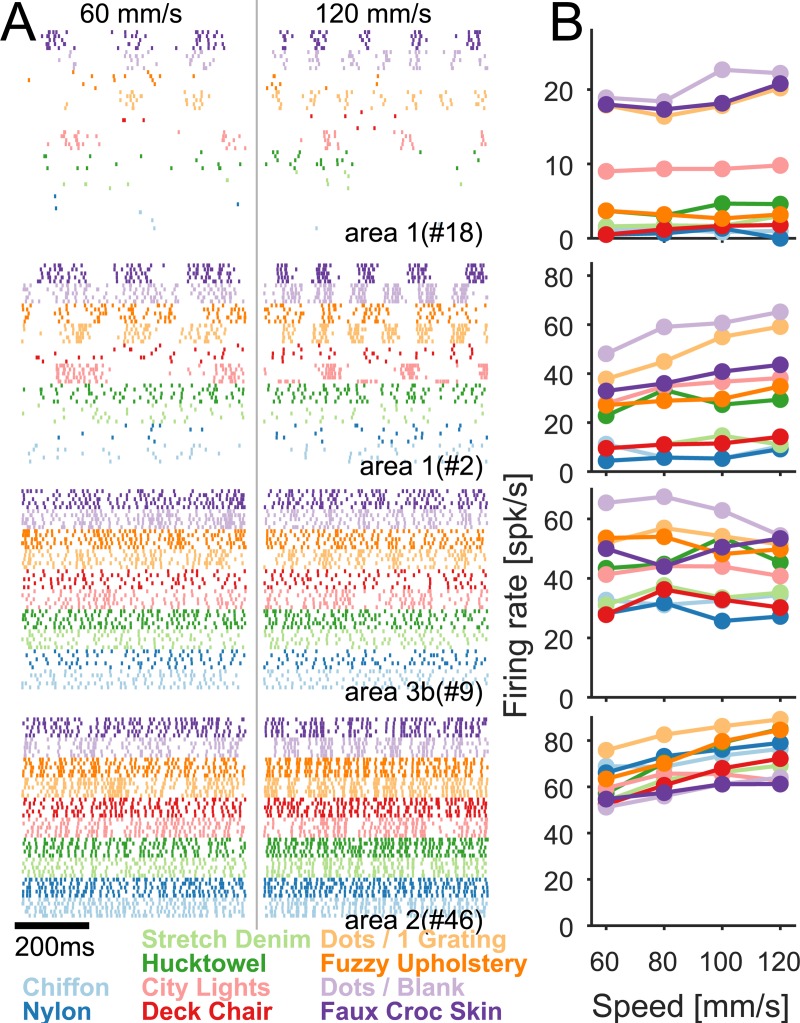
Speed dependence of the responses of cortical neurons.(A) Spiking responses of four neurons in somatosensory cortex to five repeated presentations of 10 different textures scanned over the center of their RFs at two different speeds. Neurons #2 and #46 increase their rate with speed; neurons #18 and #9 do not. (B) Mean firing rate versus speed. Each color denotes a different texture (see legend at the bottom left). Data underlying this figure can be found in S1 Data. spk, spike.